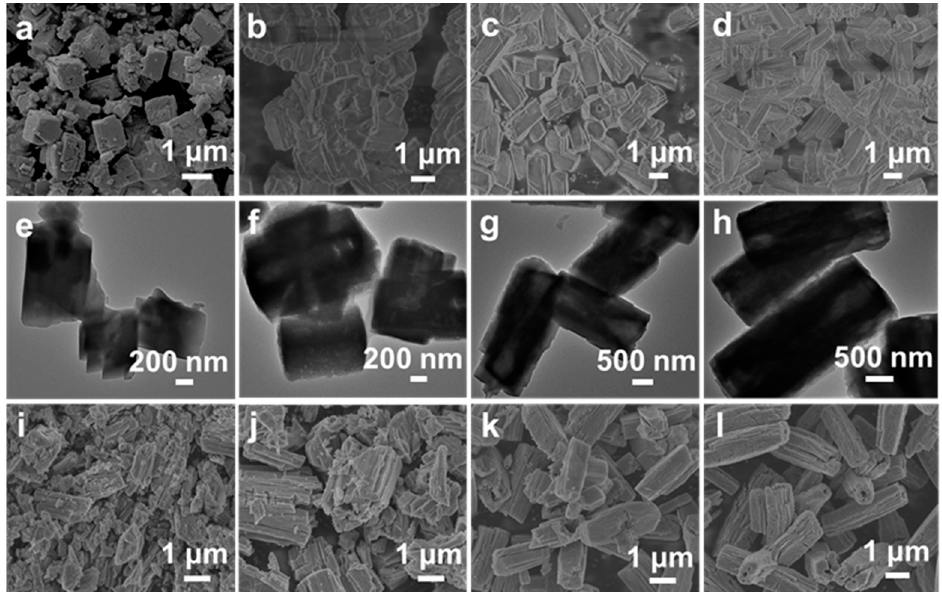
Figure 4. ( a – d ) FESEM and ( e – h ) TEM images of the ZnC 2 O 4 -MnC 2 O 4 ·2H 2 O precursor with different volumes of PEG 400: ( a , e ) 0 mL, ( b , f ) 10 mL, ( c , g ) 20 mL, ( d , h ) 40 mL. FESEM images of ( i ) ZMO-0, ( j ) ZMO-10, ( k ) ZMO-20, and ( l ) ZMO-40.